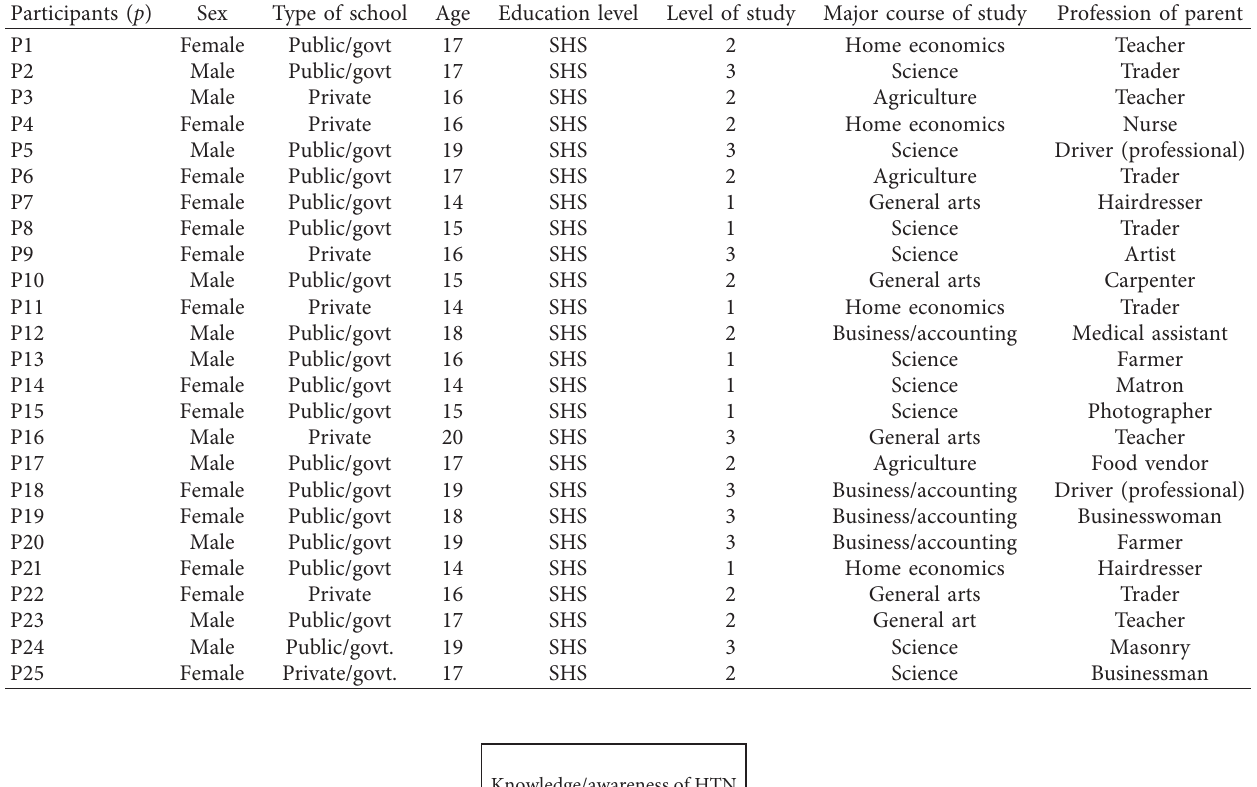
Table 1: Summary of participant